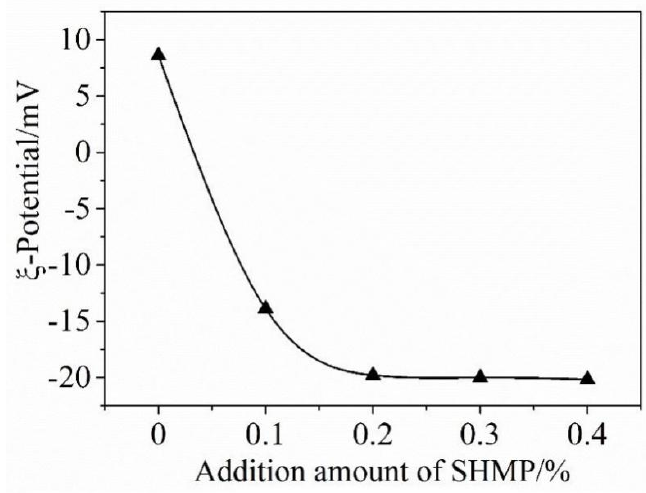
Figure 4. ζ -potential of cement particles as a function of addition amount of SHMP.